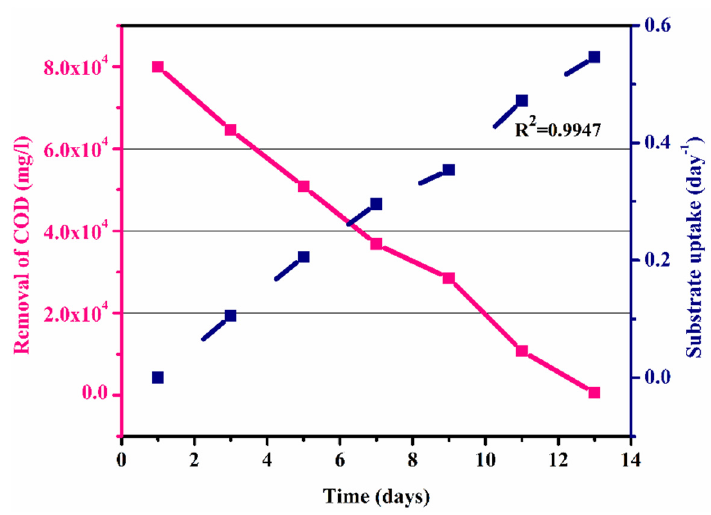
Figure 7. COD removal and substrate uptake versus time. Table 5. Solid retention time (SRT), substrate removal, and COD removal efficiency with